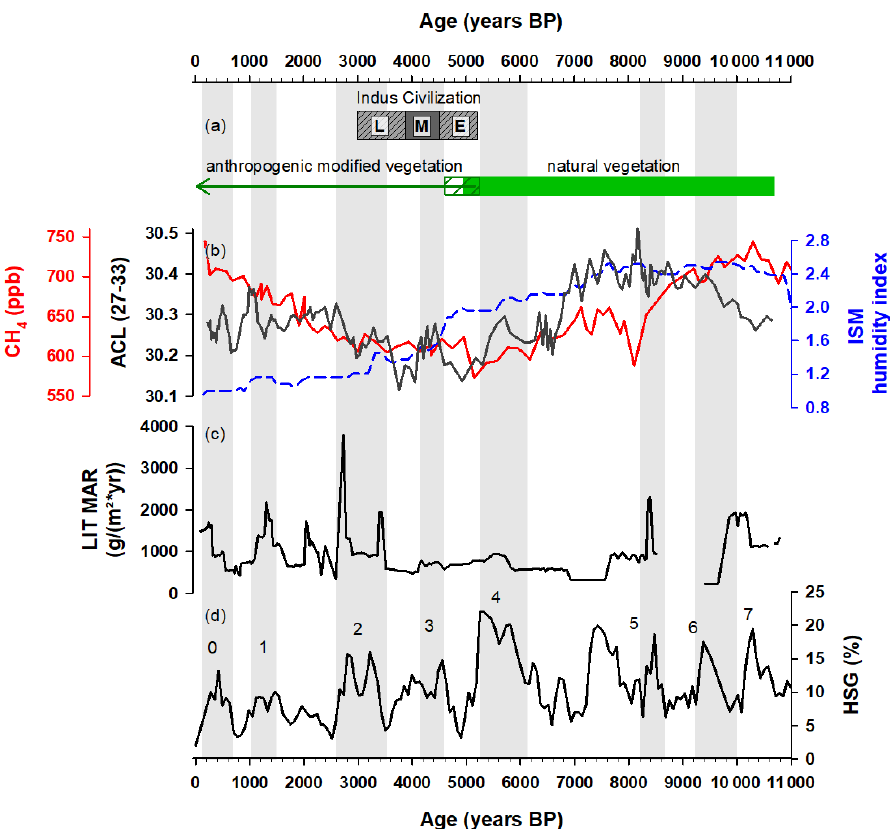
Figure 4. Environmental and anthropogenic interactions illustrated by proxy records. (a) Different phases of the Indus civilization (Giosan et al., 2012) (L = late, M = mature, E = early) and time periods of interpreted natural and anthropogenic modified vegetation (green bar and arrow) of core SO90-83KA in comparison to (b) average chain length (ACL) of the n -alkanes homologues 27–33 (black line, five- point running mean) and (c) LIT MAR of SO90-63KA. The ISM humidity index (Herzschuh, 2006) (blue) and CH 4 concentration (red) reconstruction based on Greenland ice cores (Blunier et al., 1995) are also depicted in (b) . (d) Bond events (numbered gray bars) based on the HSG drift ice record from the North Atlantic (Bond et al.,